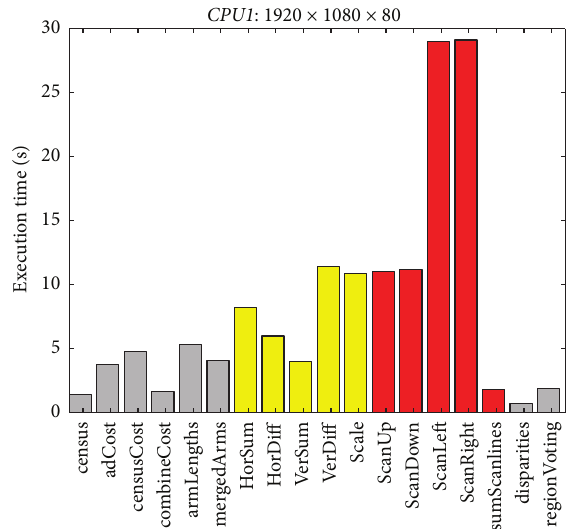
Figure 5: Runtimes that different kernels contribute to overall runtime on Maxeler CPU (denoted by CPU1) for a FullHD image pair.Yellowandredbarsindicatekernelsinaggregationandscanline phase, respectively.